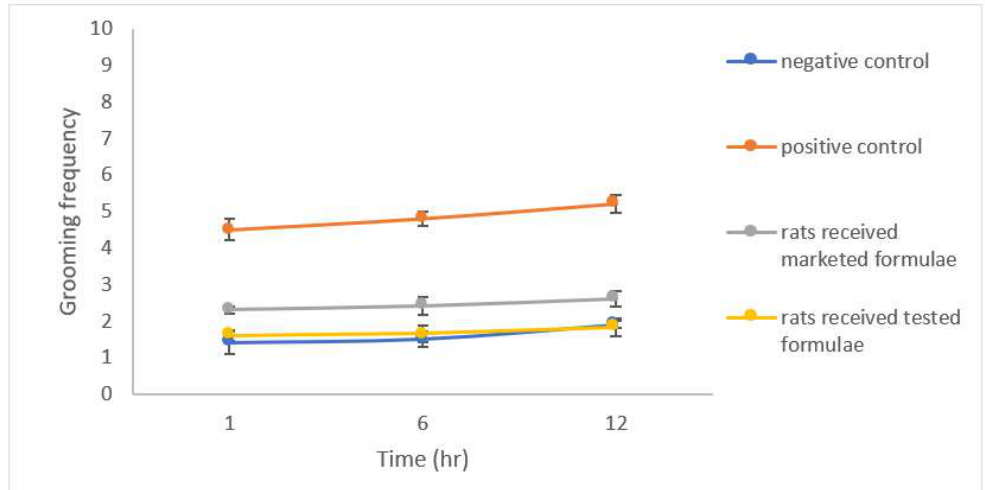
Figure 11. Grooming frequency for different groups of rats.